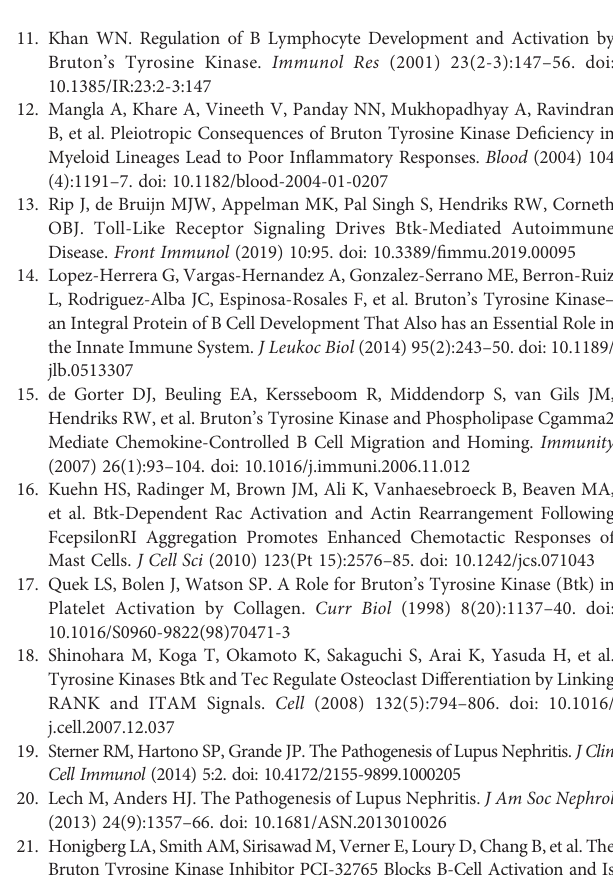
Supplementary Table 1 | Full enrichment excel fi le. Supplementary Table 2 | Full OFF-X excel fi le with drug score and # of